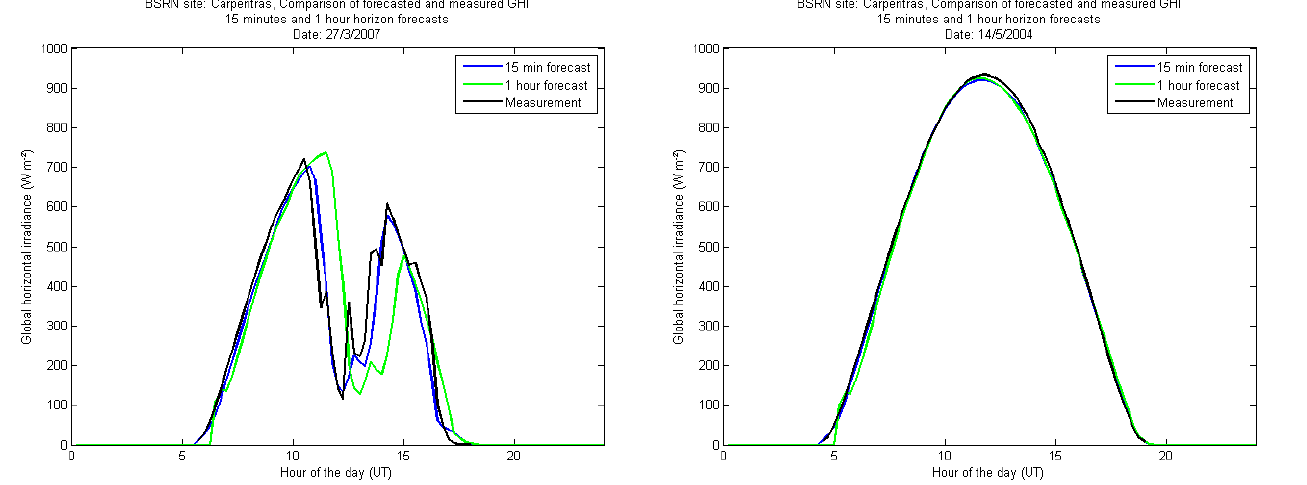
Figure 4. Daily profiles of 15min GHI of the measurements (black line), the 15min ahead forecast (blue line) and 1h ahead forecast (green line) at Carpentras for 14 May